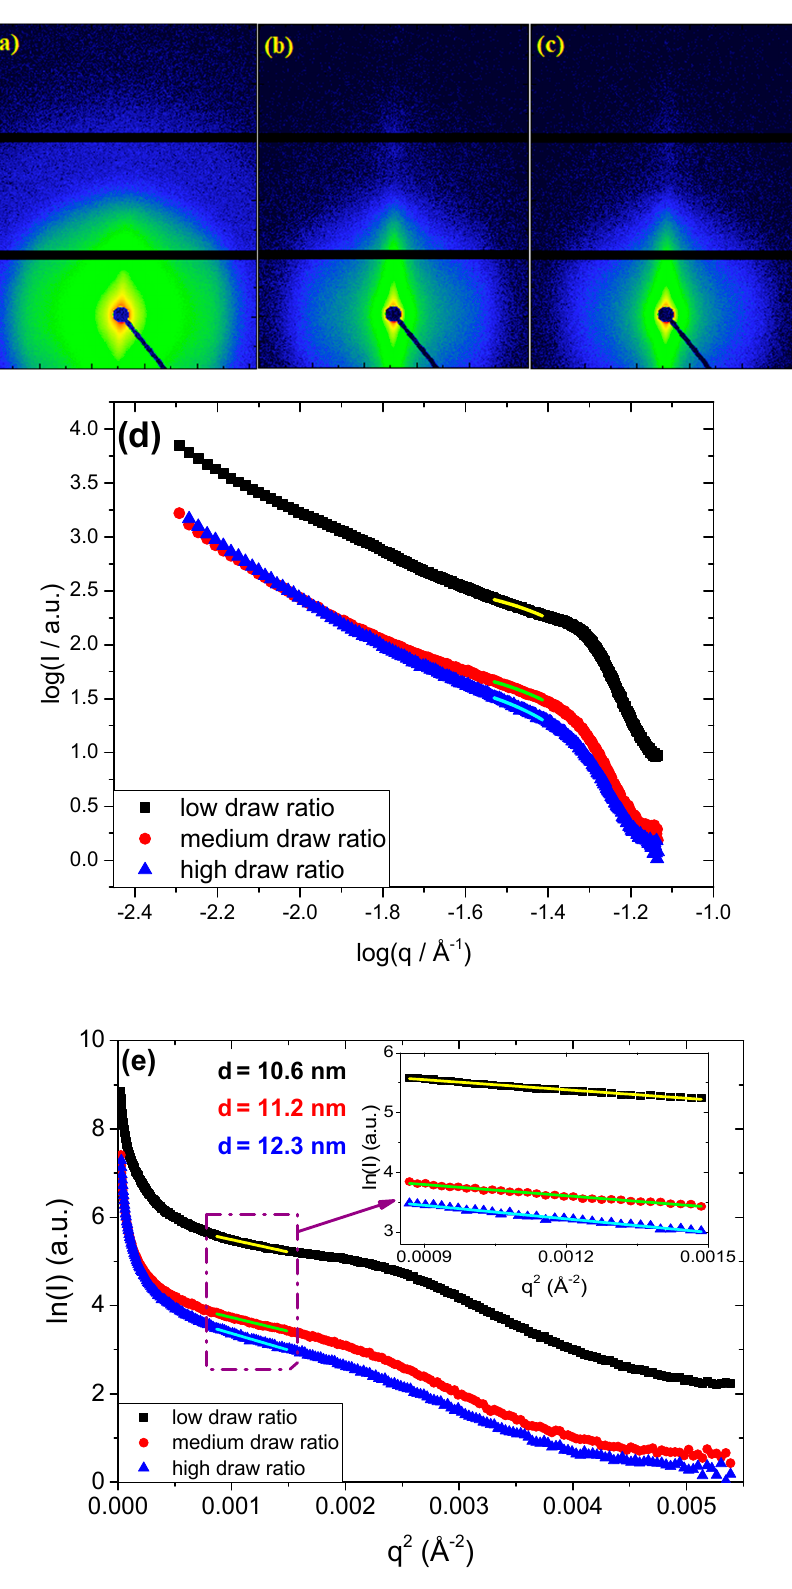
Figure 8. 2D SAXS patterns of UHMWPE / gold nanocomposites at ( a ) low draw ratio (DR5), ( b ) medium draw ratio (DR70), and ( c ) high draw ratio (DR150). After integration over all azimuth angles, we obtained the 1D profiles in ( d ) log-log representation and ( e ) Guinier plot of the SAXS patterns, fitted with the Guinier law. The diameters of the gold nanoparticles as obtained by the Guinier law for spherical nanoparticles are presented within the graph.